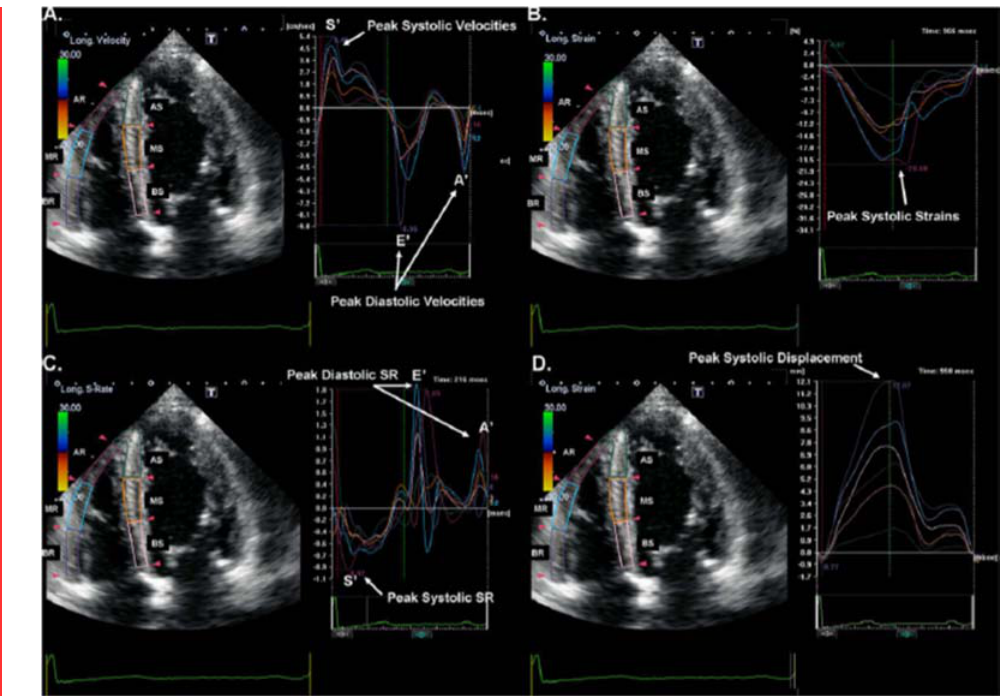
Figure 7. Apical 4-chamber view with 2D speckle imaging of the LV septum and RV free wall in a normal older patient. The images display longitudinal velocity (A), strain (B), strain rate (SR) (C), and displacement (D) curves. A’, Late diastolic waveform; AR, apical right ventricle; AS, apical septum; BR, basal right ventricle; BS, basal septum; E’, early diastolic waveform; MR, mid right ventricle; MS, mid septum; S’, systolic waveform. Adapted from Horton K, et al. Assessment of the right ventricle by echocardiography: a primer for cardiac